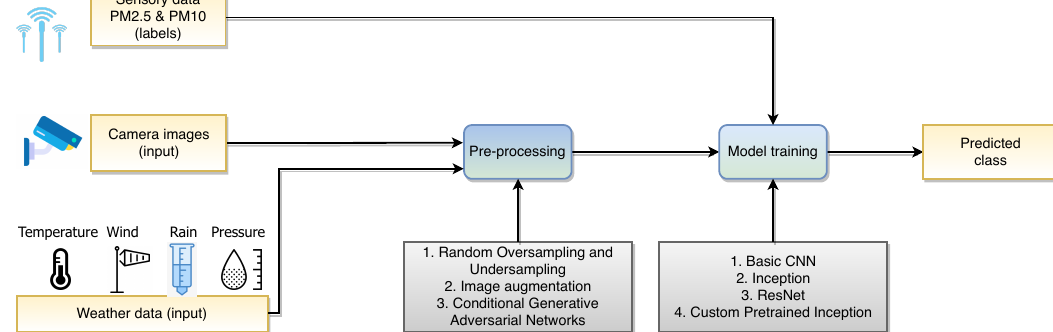
Figure 2. Workflow of the proposed methodology for air pollution